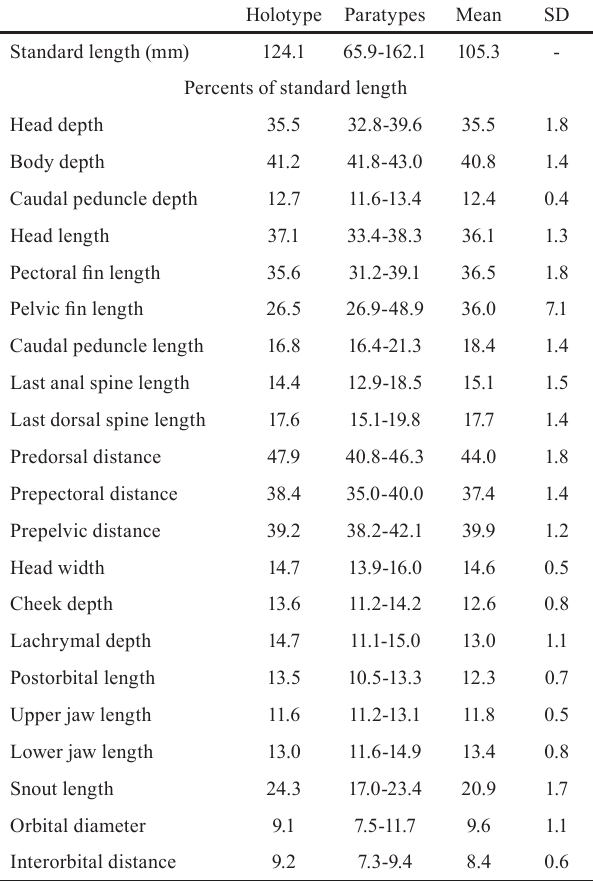
Table 1. Morphometric data for holotype and 19 paratypes of Geophagus mirabilis , new species. SD = standard